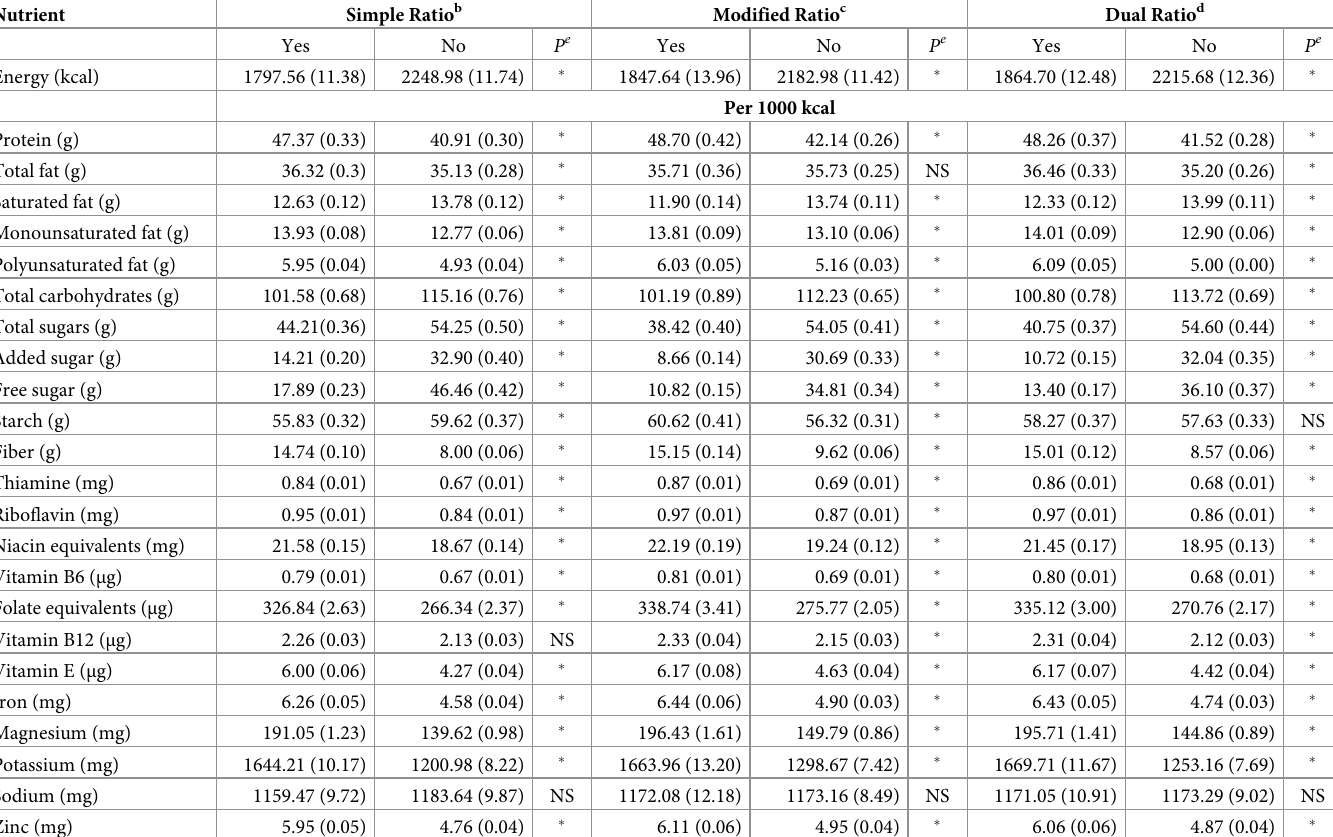
Table 3. Energy-standardised (per 1000kJ) daily macro- and micronutrient intakes for adults in the 2011–12 Australian National Nutrition and Physical Activity Survey (NNPAS) who achieved or did not achieve each carbohydrate quality ratio a .